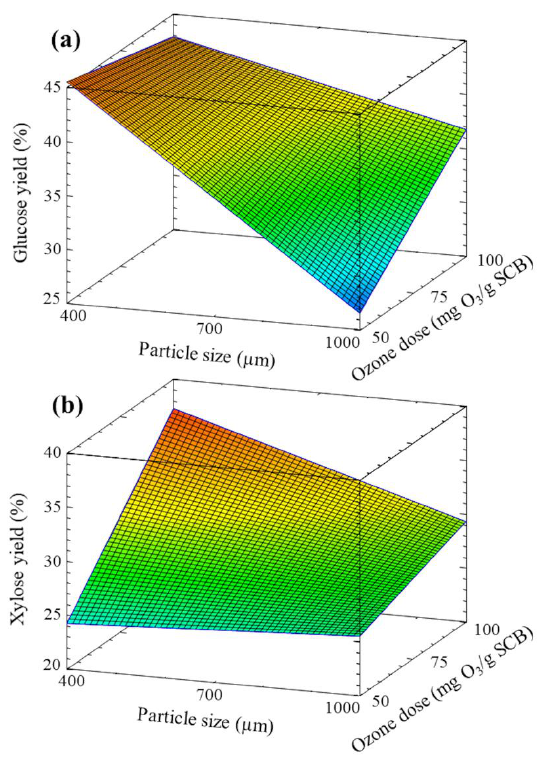
Figure 5. Estimated response surfaces for ( a ) glucose and ( b ) xylose yields at 45% w/w moisture